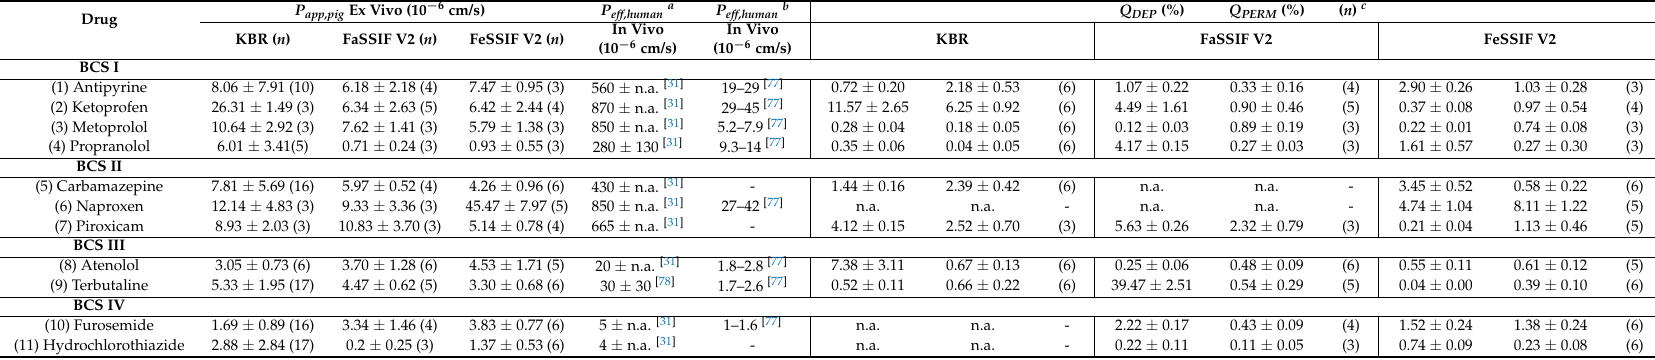
Table 2. The apparent permeability coefficients for passive absorption across porcine intestine, P app,pig , from KBR and the biorelevant media FaSSIF V2 and FeSSIF V2 and the Q DEP and Q PERM values determined with viable porcine intestine ex vivo (n ≥ 3): The effective permeability coefficients a,b for absorption in vivo in humans, P eff, human , are given for